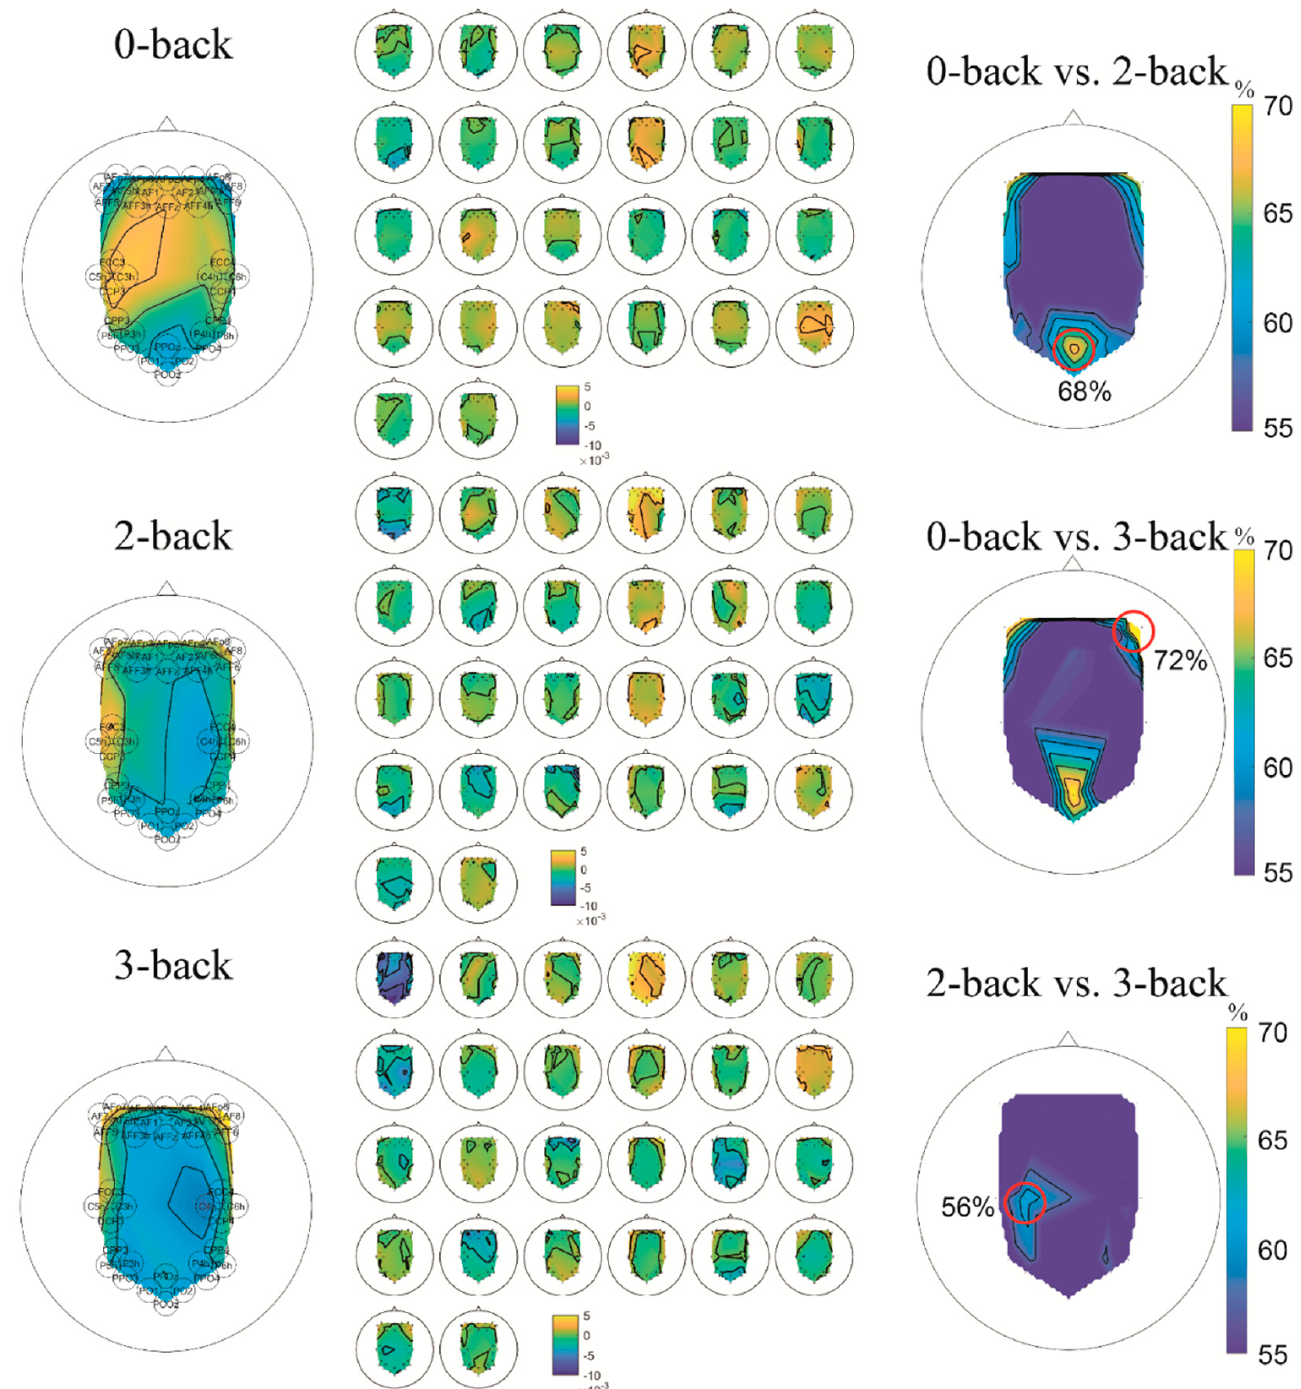
Figure 7. Topographic map of the fNIRS HbR features. Left: average; Middle: each participant; Right: Accuracy using each-channel HbR feature as the input. The area that provided the highest accuracy is highlighted.